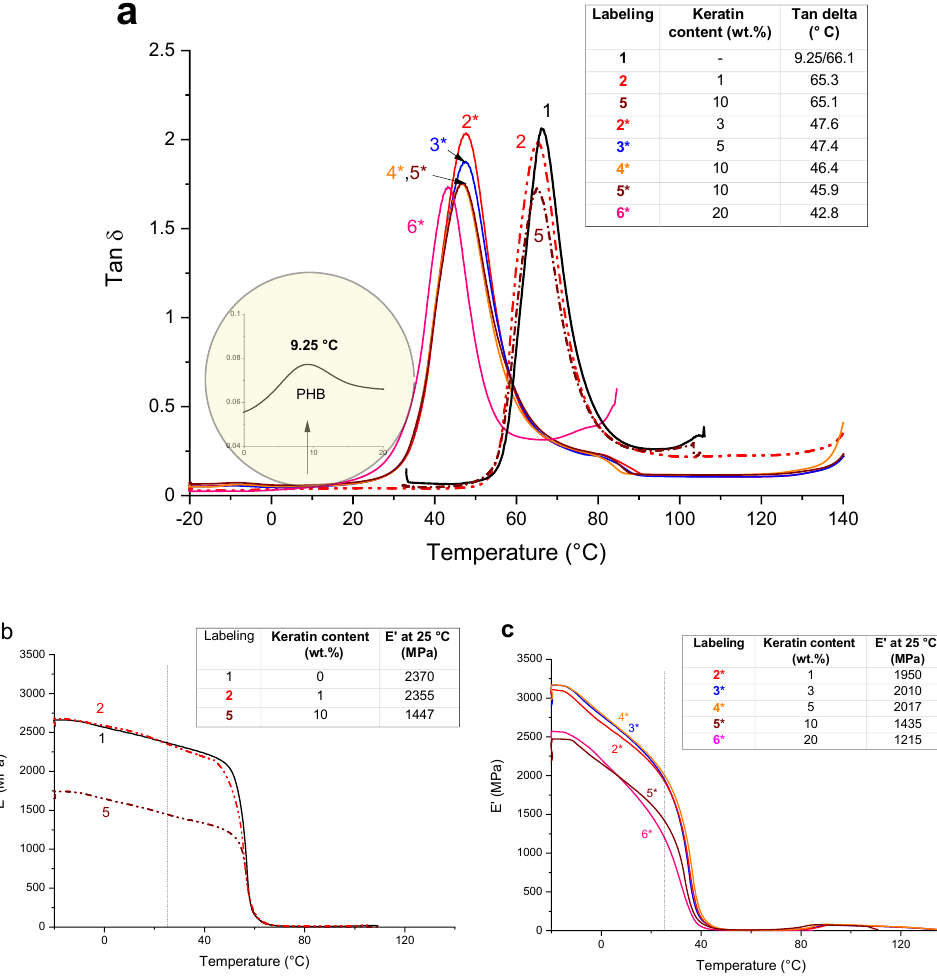
Figure 4. Evolution of ( a ) loss factor ( tan δ ) and ( b ), ( c ) storage moduli ( E ′ ) with temperature for PLA / PHB before and after addition of 1 wt % and 10 wt % keratin and plasticized PLA / PHB / ATBC blend filled with 1 wt %, 3 wt %, 5 wt %, 10 wt % and 20 wt % of the keratin.